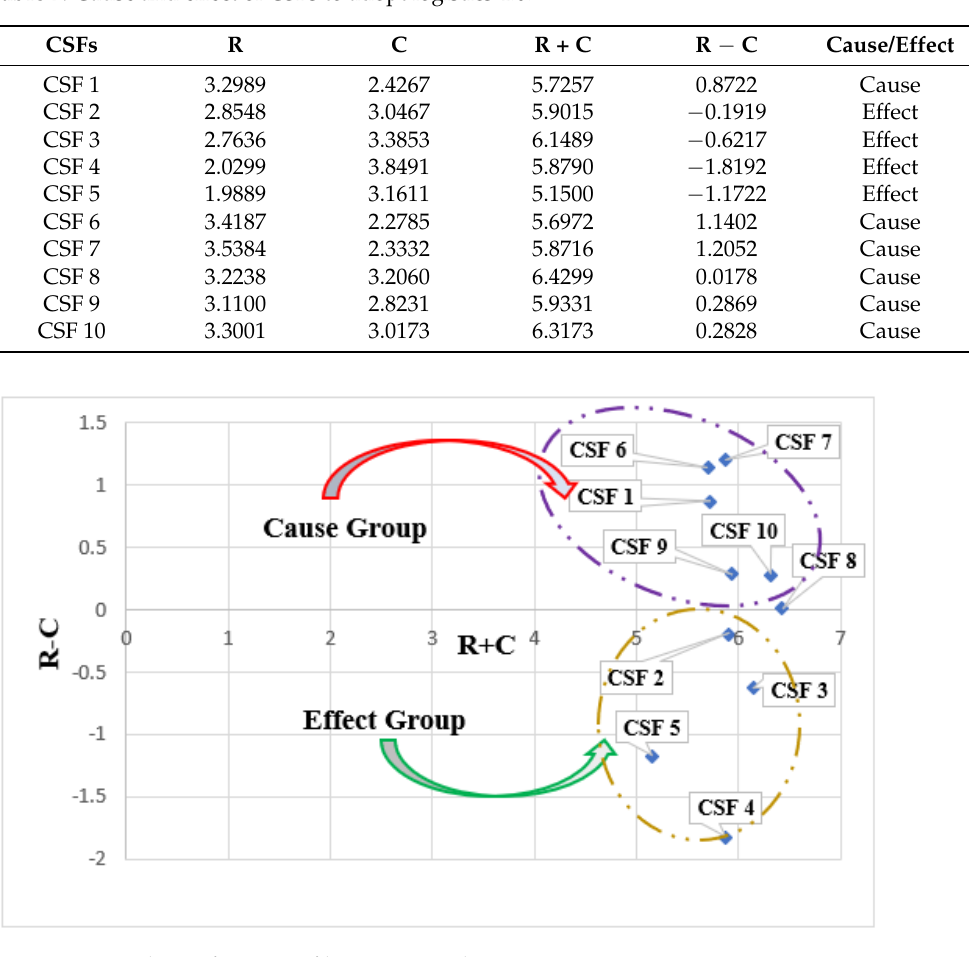
Figure 2. Causal map for CSFs of logistics 4.0 adoption.